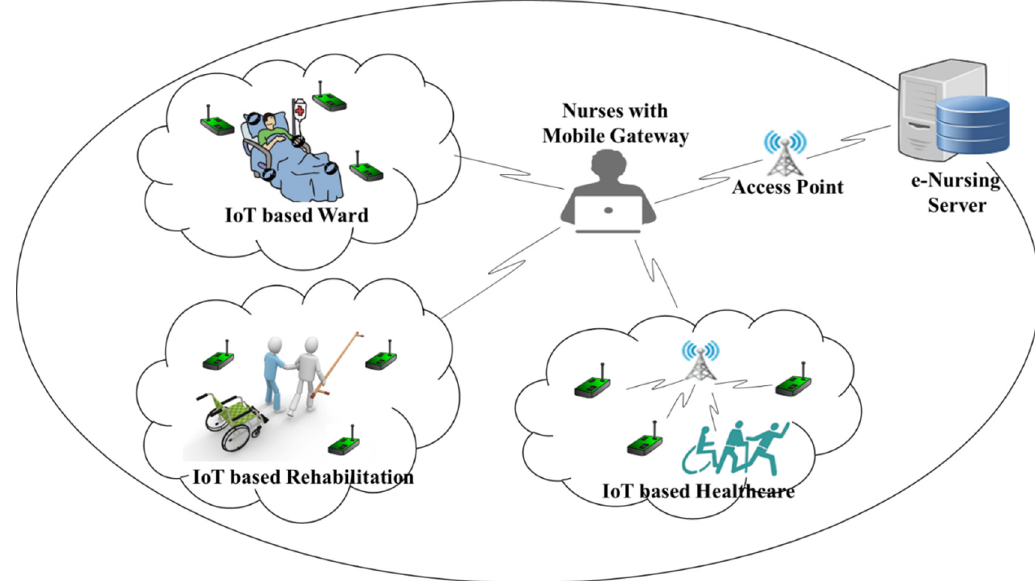
Figure 1. The proposed IoT ‐ based communication architecture.